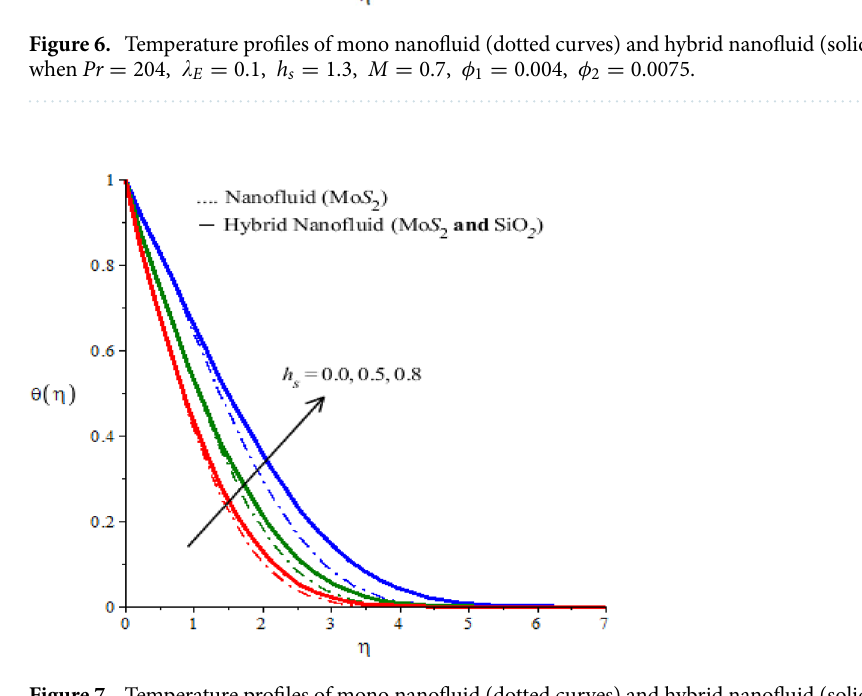
Figure 7. Temperature profiles of mono nanofluid (dotted curves) and hybrid nanofluid (solid curves) for h s when Pr = 204, (cid:31) E = 2.0, n = 2, M = 0.001, φ 1 = 0.004, φ 2 =